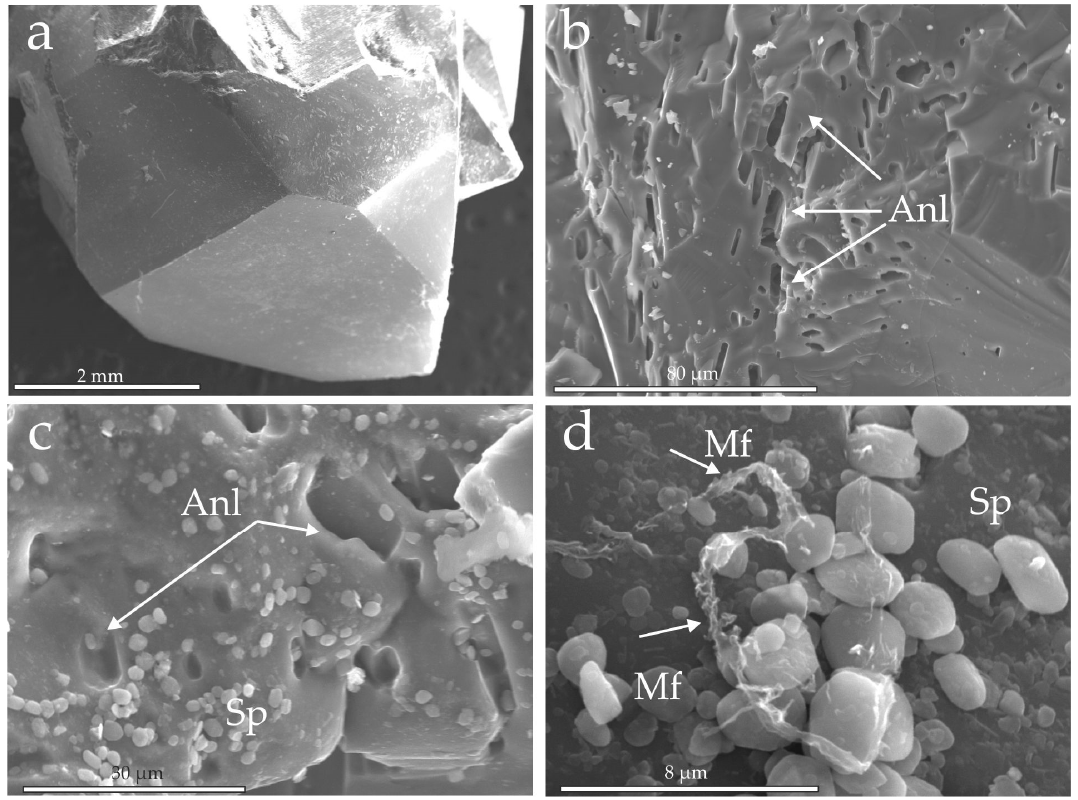
Figure 5. Scanning electron photomicrographs of Quartz (Q) crystals: ( a ) Idiomorphic edge of a bipyramidal quartz crystal with no signals of transport or dissolution; ( b ) High-resolution secondary electron images of quartz surface with abundant anhydrite laths (Anl); ( c ) Detail of the quartz central area of the quartz crystal with anhydrite laths, coated by quartz spherules (Sp); ( d ) Detail of the silica spherules (composed of Si, Fe, and Al) and microbial filaments (Mf) indicating the formation of the quartz within a saline environment rich in organic matter.